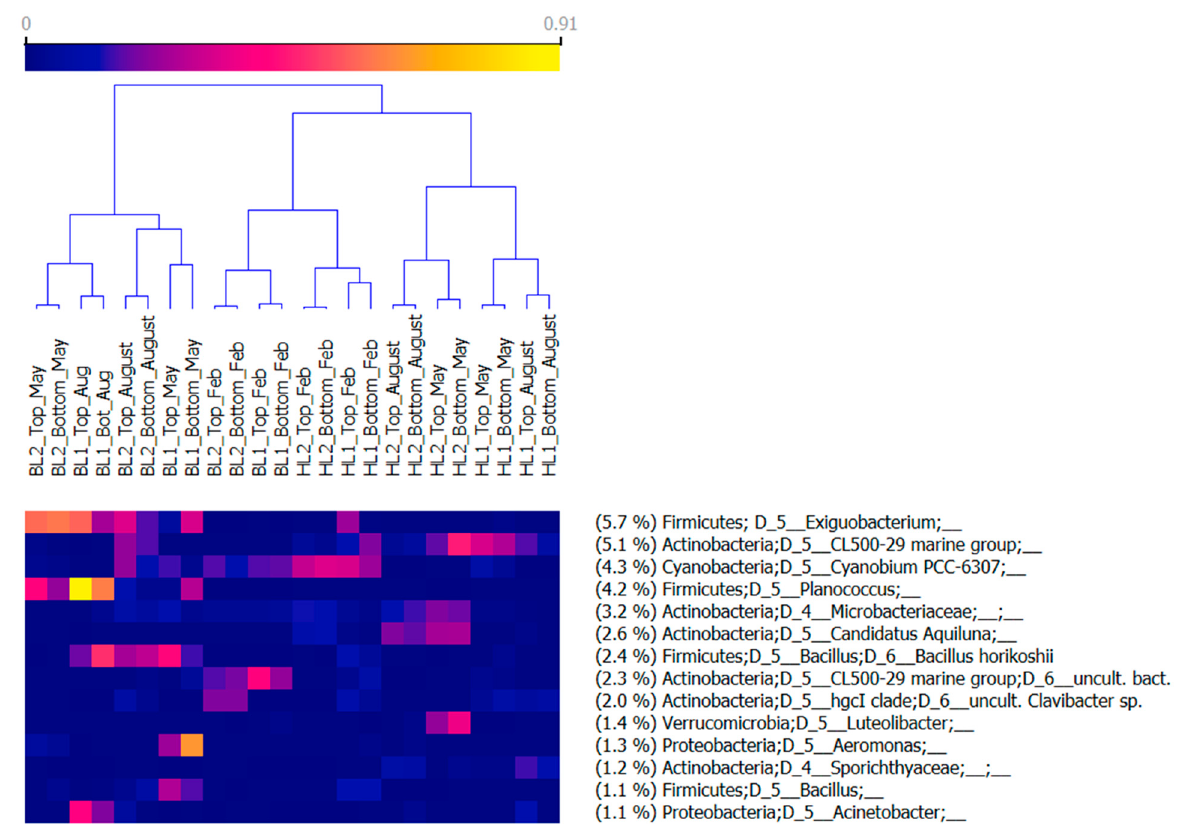
Figure 8. Heat map of overall most relatively abundant microbes (>1%) from pit lakes in the Bowen Basin, Queensland and the Hunter Basin, New South Wales, Australia. Heat map reflects data from most abundant replicate ( n = 3 per lake, time and depth unless otherwise indicated in methods). Range of relative abundances per a priori group can be found in Supplementary Table S3, and the heat map split by catchment can be found in Supplementary Figure S2.